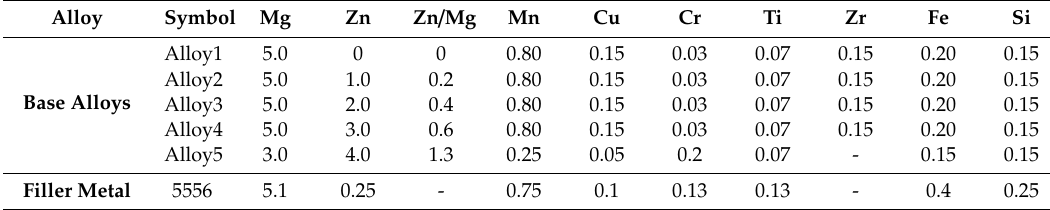
Table 1. Experimental alloy composition in wt% (Balance: